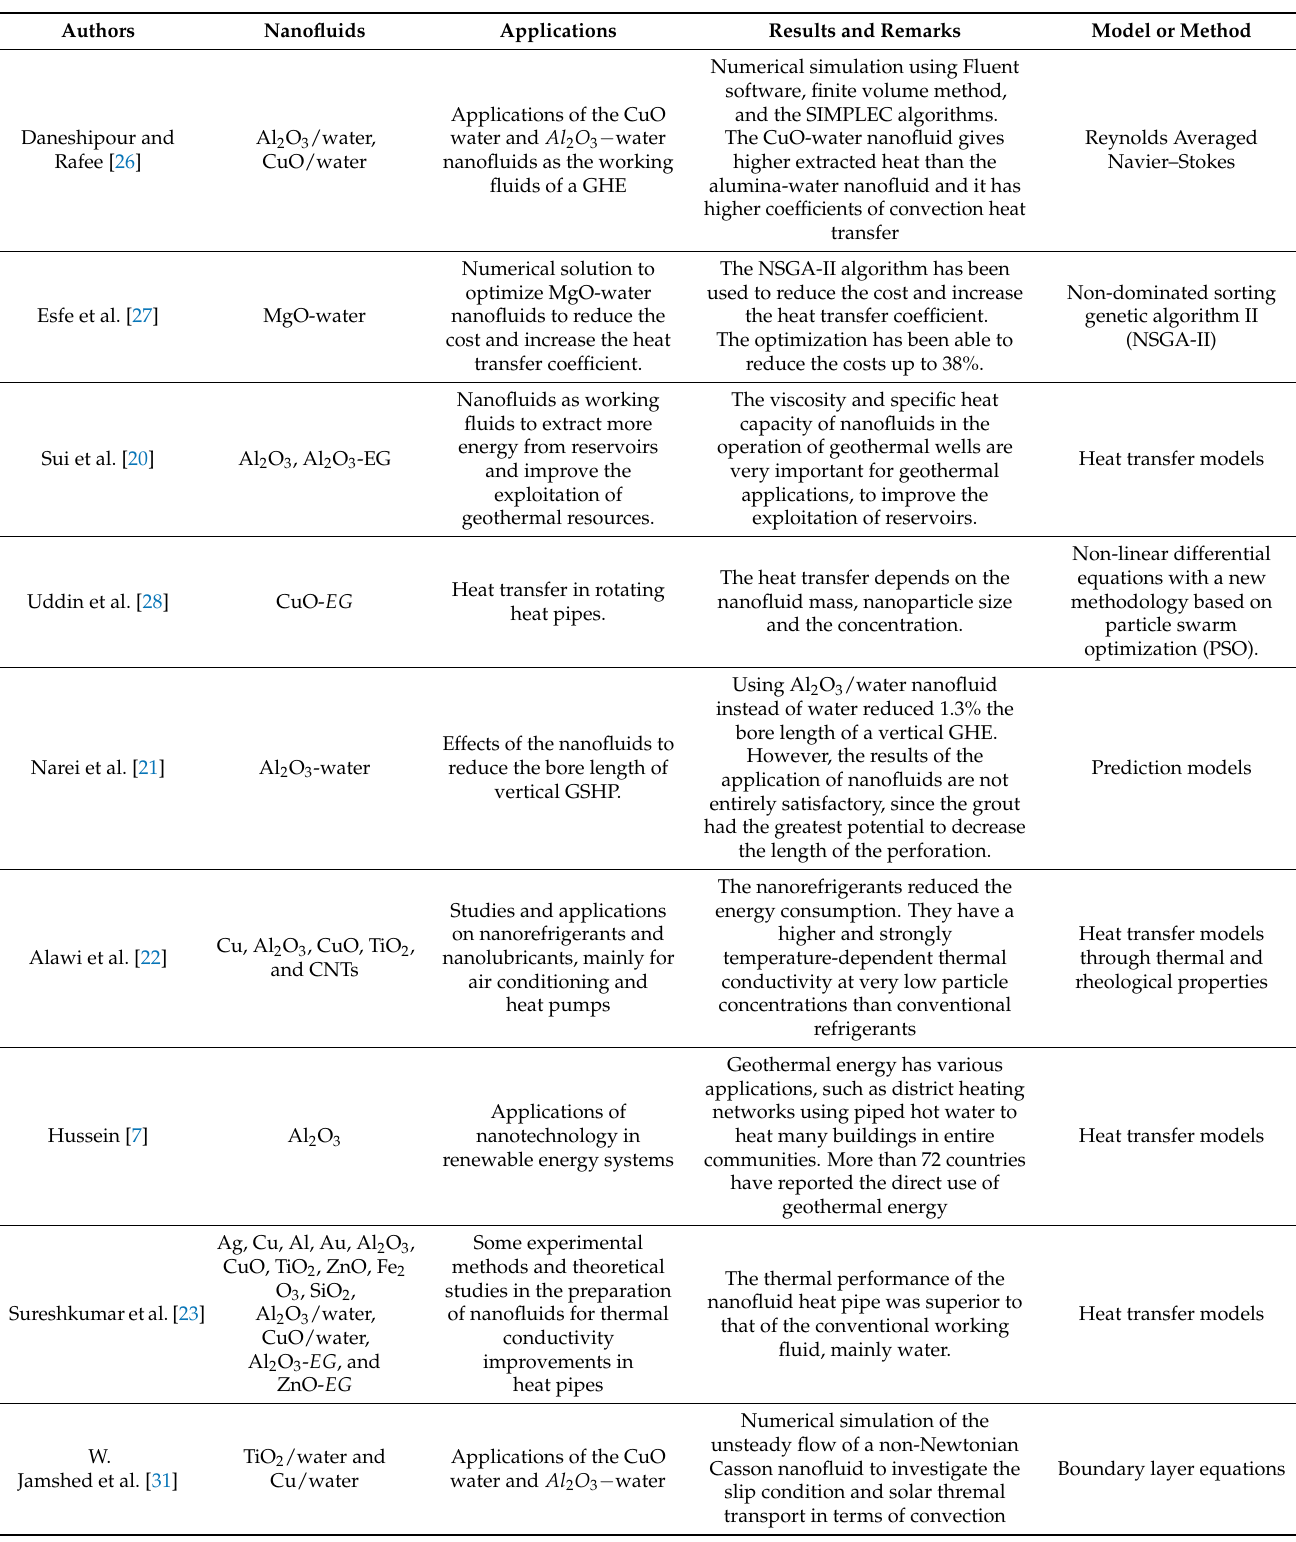
Table 2. Summary of theoretical and numerical studies on heat exchanger pipes using nanofluids